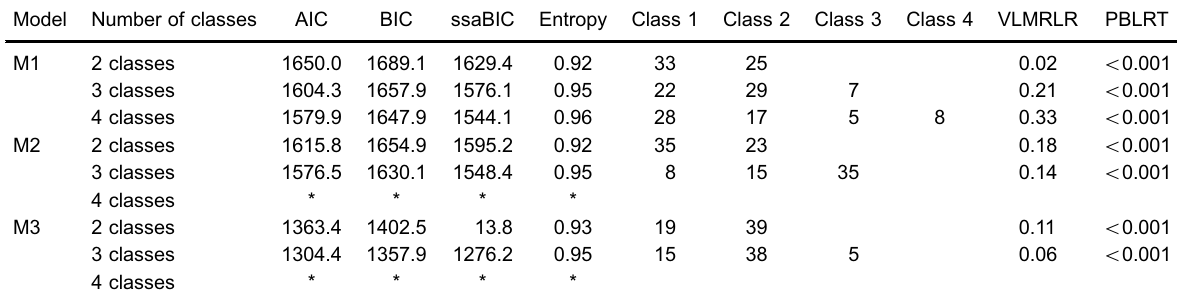
Table 2. Model fi t